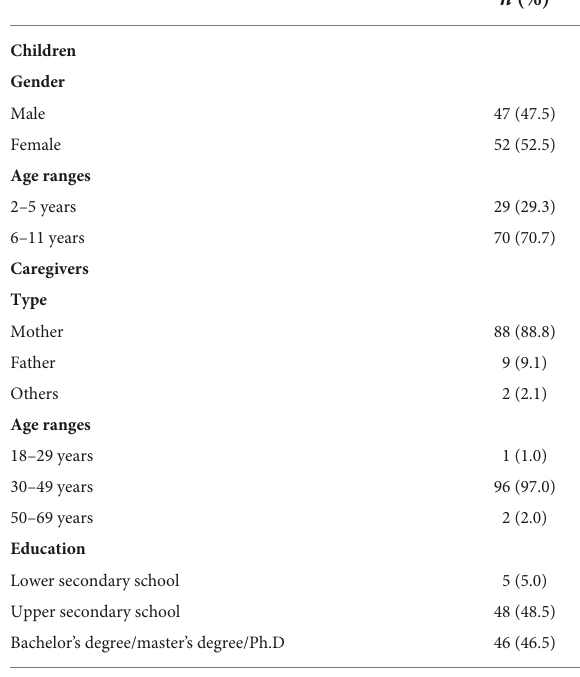
TABLE 1 General characteristics of children and